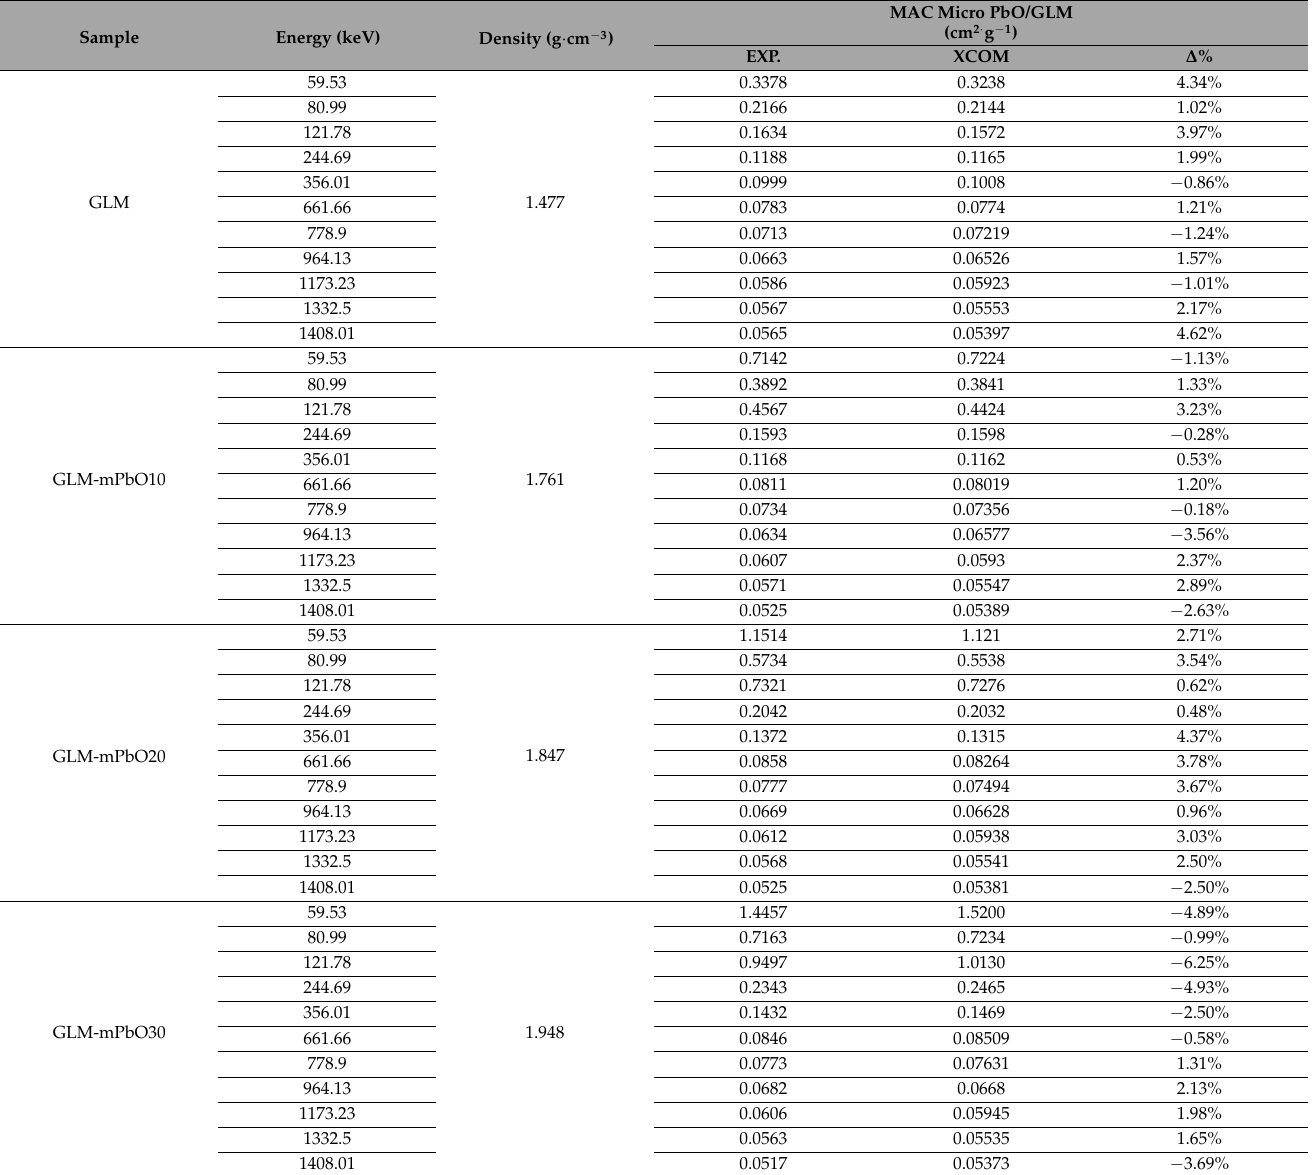
Table 4. Experimental and theoretical values of MAC for GLM, GLM-mPbO10, GLM-mPbO20, and GLM mPbO30 at different photon